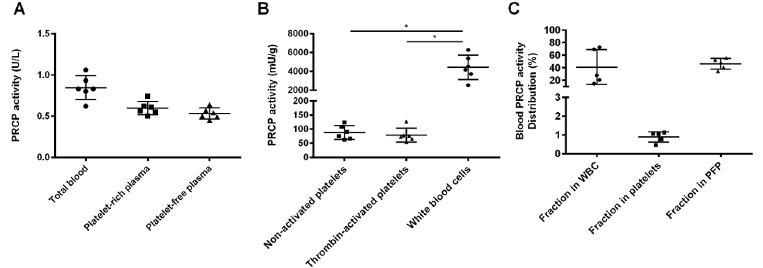
Fig 1. PRCP activity in human circulation. (A) PRCP activity was measured in total lysed blood, platelet-rich and platelet-free plasma but no significant changes were found (p = 0.174). (B) PRCP activity was significantly higher in lysed white blood cells compared to resting and thrombin-activated blood platelets (p = 0.028). (C) PRCP activity measured in human blood is mainly attributed to white blood cells and the plasma fraction. ( (cid:3) p < 0.05, n = 4–6 per